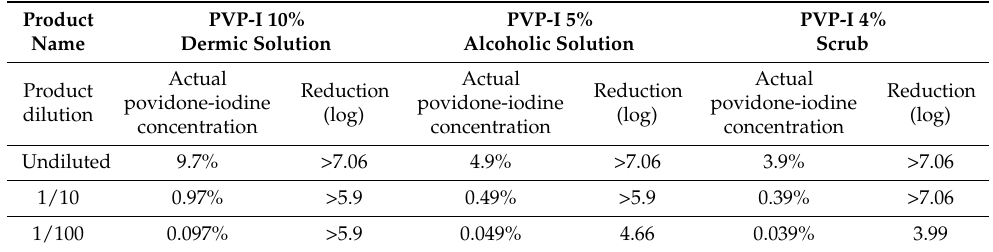
Table 1. Log reduction of Cutibacterium acnes when treated with different betadine